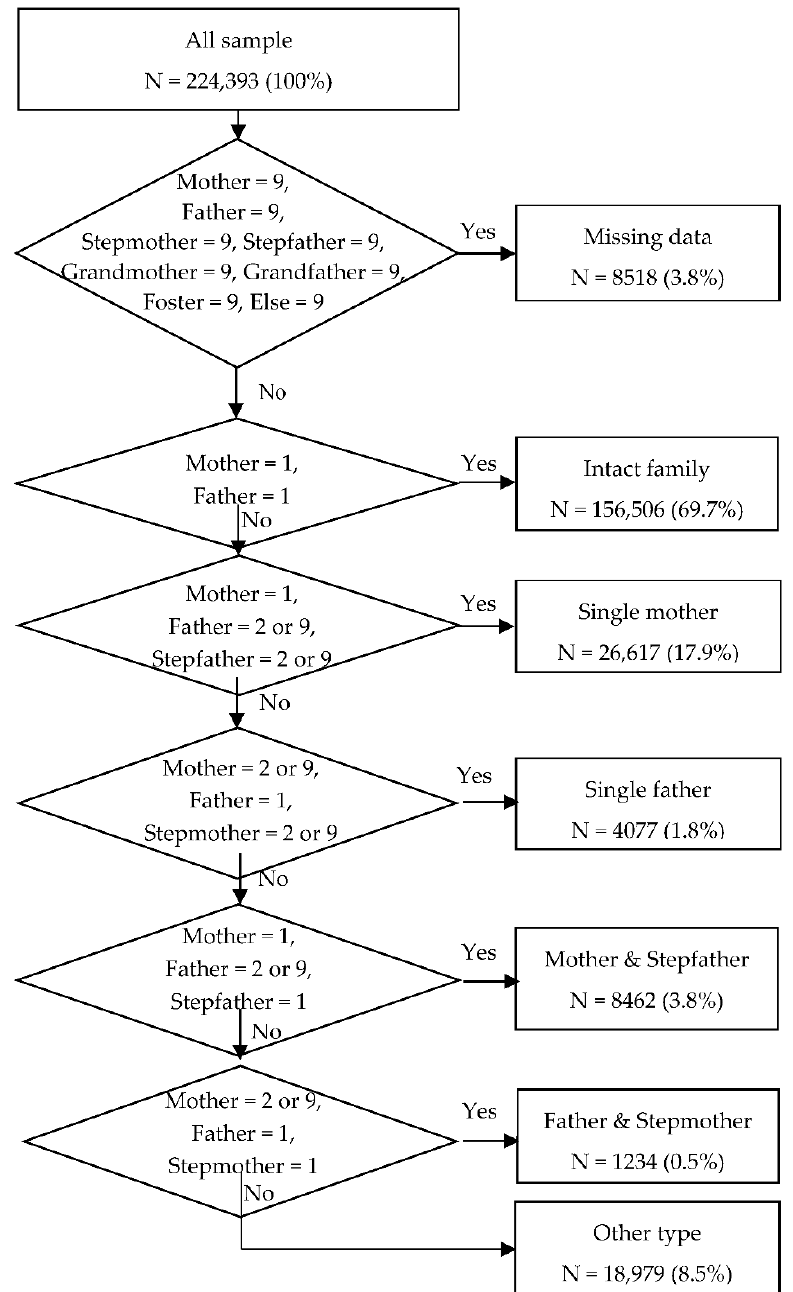
Figure 1. Flow diagram of the classification of families by the type of structure. Sample size of the HBSC survey in 2018 is presented. Codes of items: 1 = yes; 2 = no; 9 = missing; Foster—living in foster home or children’s home; Else— living with someone or somewhere else.